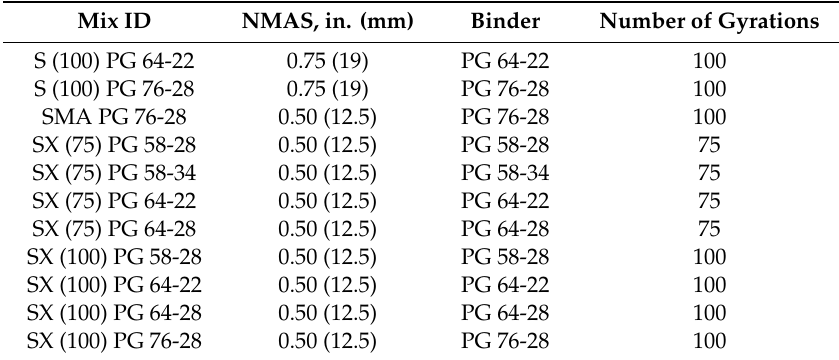
Table 1. List of 11 mixtures used in this